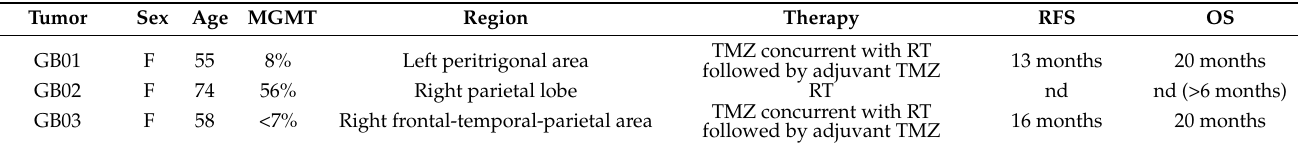
Table 1. Patient clinical and demographic data. Age, age at diagnosis. MGMT (O-6-methylguanine-DNA methyltransferase), percentage of MGMT promoter methylation. Region, tumor location and surgical resection area. Therapy, Radiotherapy (RT) and chemotherapy with temozolomide (TMZ). RFS, recurrence-free survival. OS, overall survival.